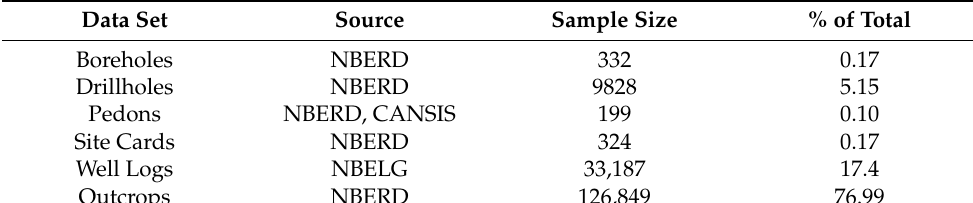
Table 2. Overview of DTB datasets acquired for analysis including source, sample size, and overall representation of each dataset including the overall dataset used for modelling. Note: Sample size represents all samples in the original datasets prior to data filtering.